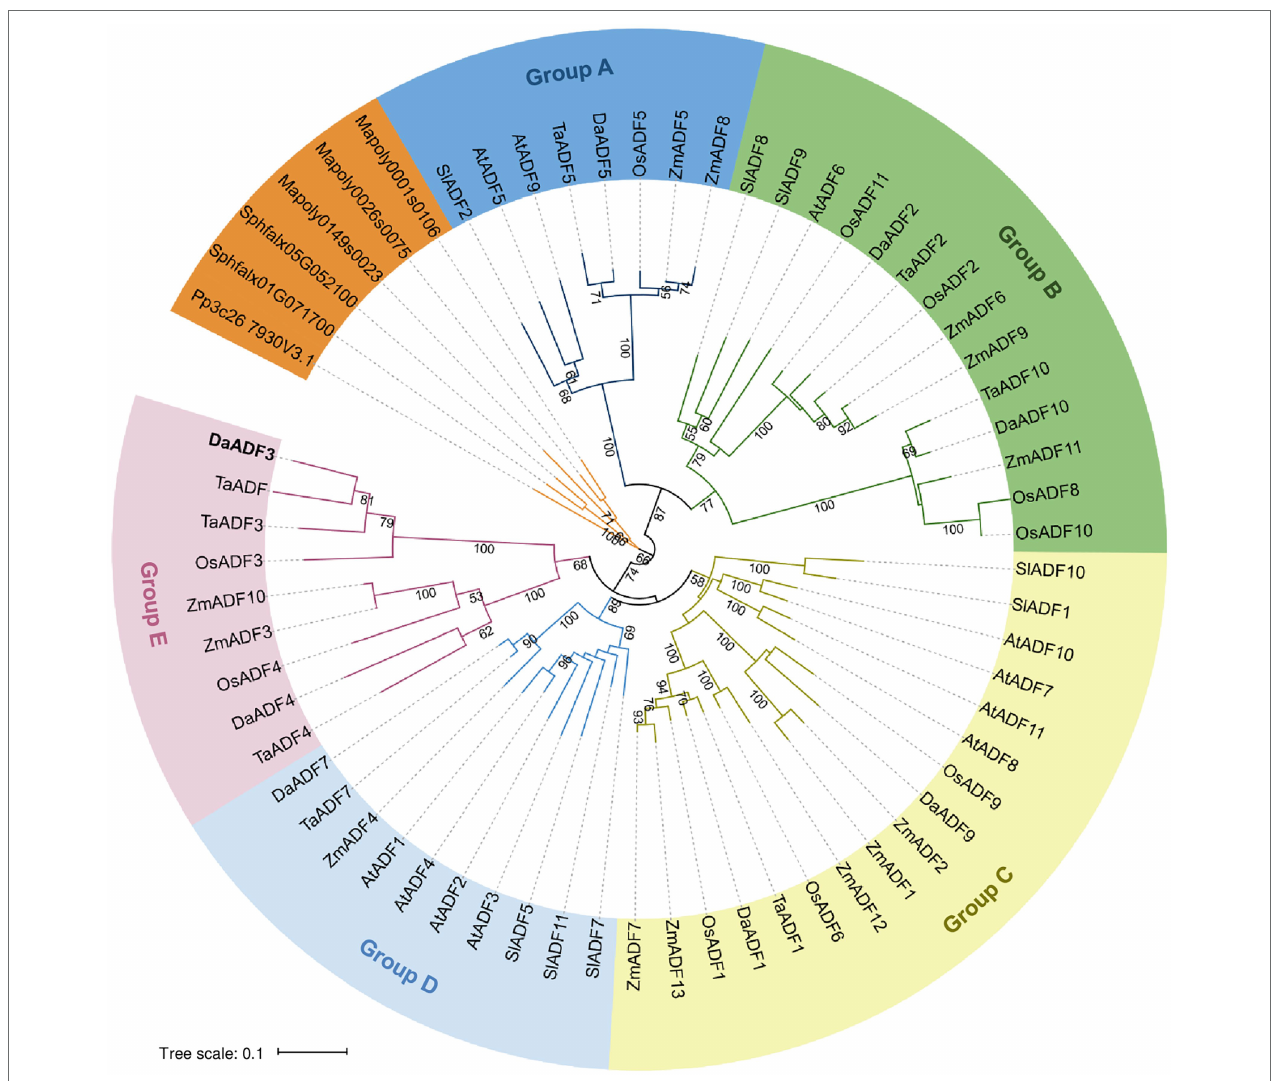
FIGURE 1 | Phylogenetic analysis of actin depolymerizing factor (ADF) proteins. The full-length amino acid sequences of DaADFs and homologs from other plants and algae were retrieved from the GenBank database and proofread. Phylogenetic trees were constructed from the datasets using the neighbor-joining method based on the JTT matrix-based model using the MEGA X software. Evolutionary distances were computed using the JTT matrix-based method. The ADF members were divided into five groups ( A to E